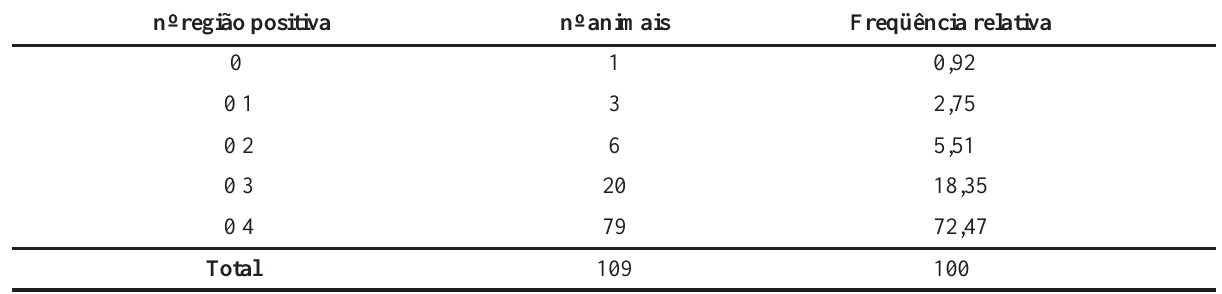
TABELA 2 - Freqüência relativa da ocorrência de Helicobacter à coloração pelo Giemsa, quando analisada as 4 regiões